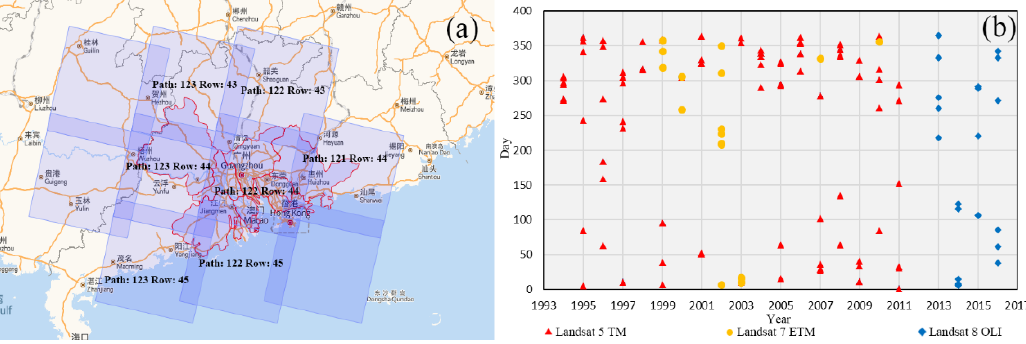
Figure 2. ( a ) The path and row numbers of the used Landsat images; ( b ) acquisition dates of the dataset.